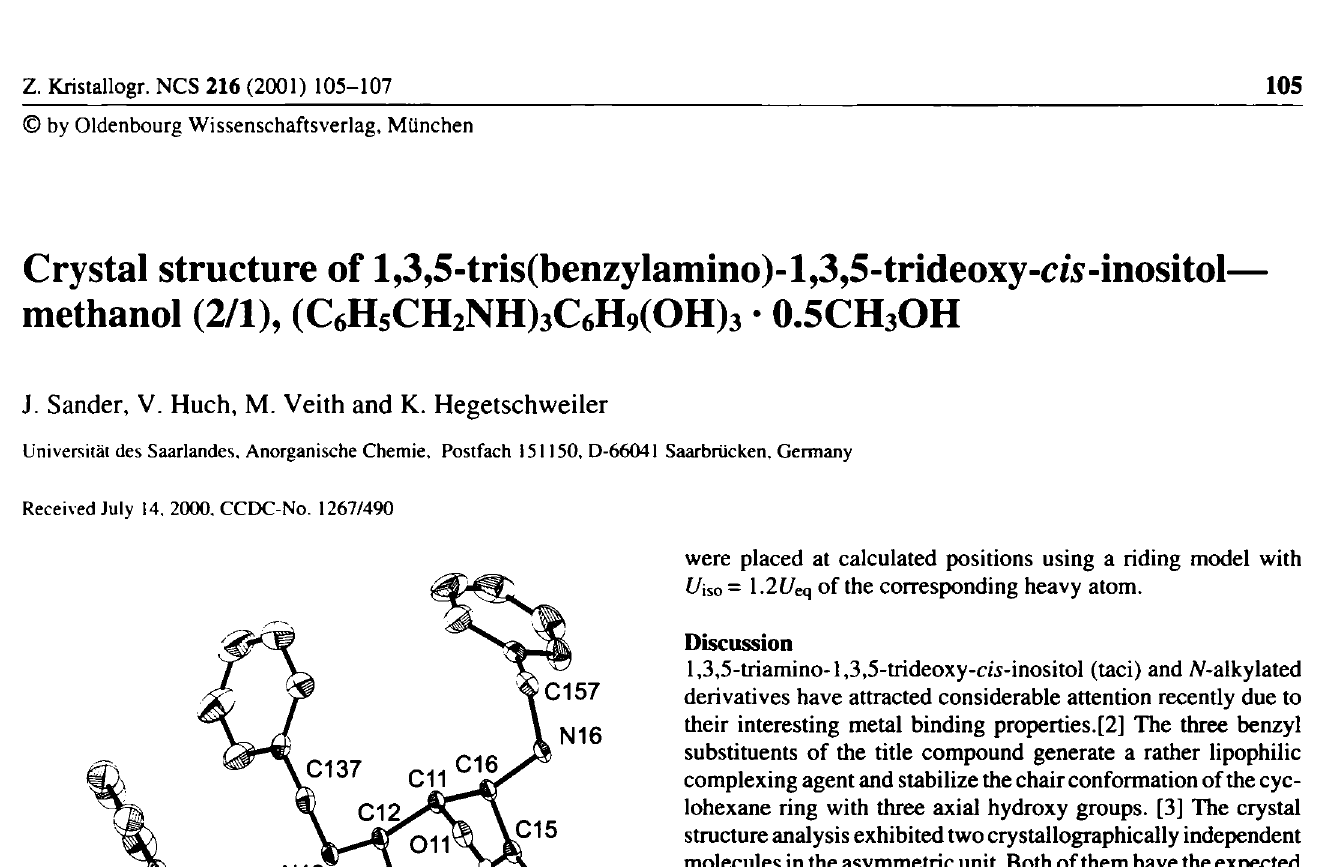
Table 1. Data collection and handling.